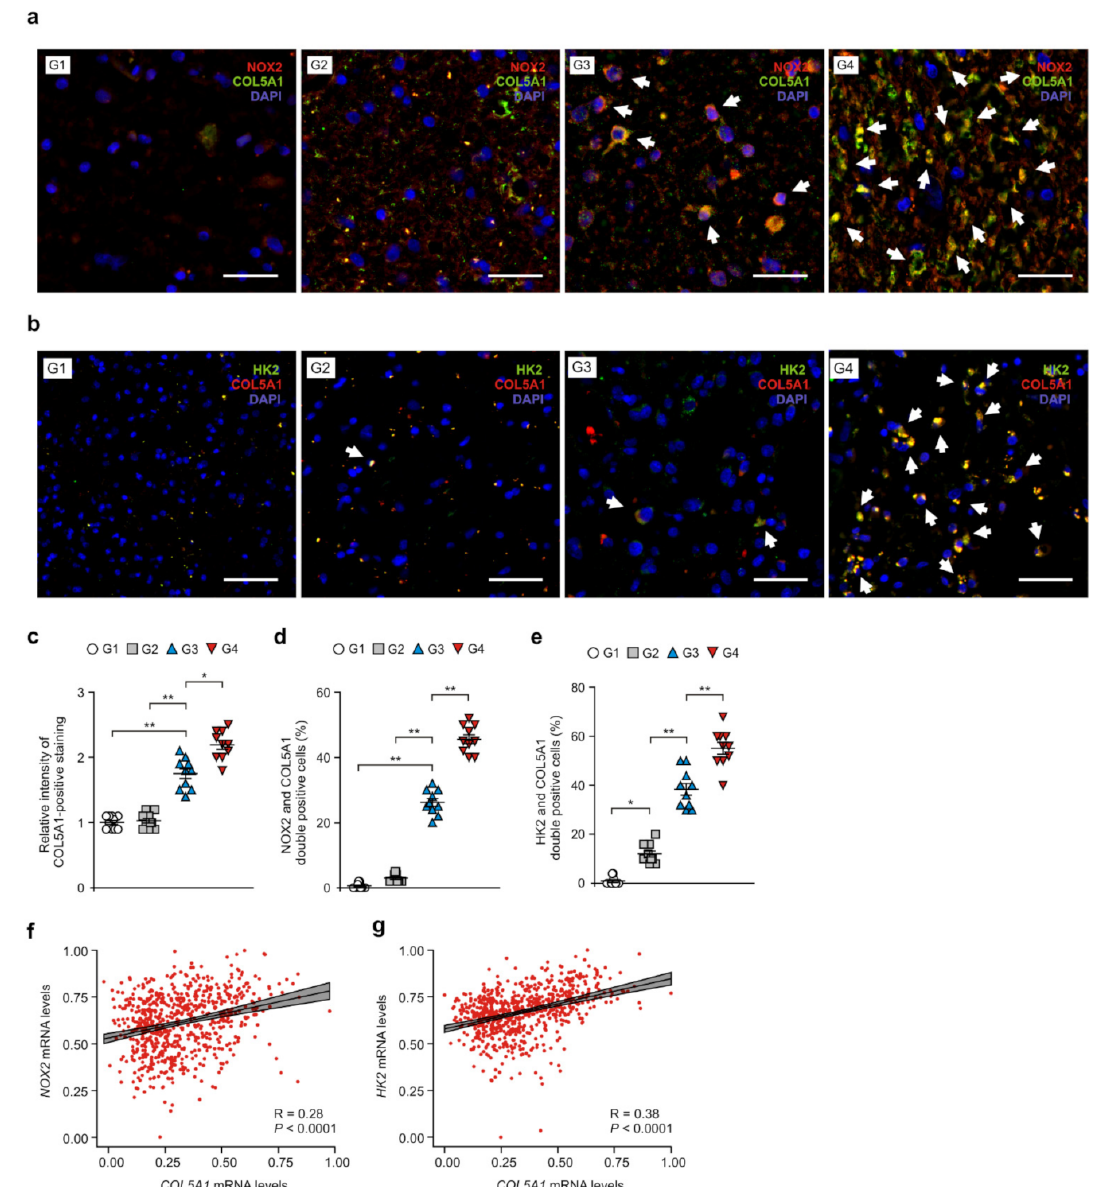
Figure 6. NOX2 and HK2 contributes to the gain of the COL5A1-mediated mesenchymal phenotype in patients with GBM. ( a ) Representative immunofluorescence images of NOX2 and COL5A1 staining in patients with GBM (G4), G3 glioma (G3), G2 glioma (G2), and G1 glioma (G1) showing NOX2 (red), COL5A1 (green), and DAPI-stained nuclei (blue) (n = 3 per group, n = 10 images per individual subject). Scale bars, 20 µ m. White arrows indicate NOX2 and COL5A1-positive cells. ( b ) Representa- tive immunofluorescence images of HK2 and COL5A1 staining in patients with GBM (G4), G3 glioma (G3), G2 glioma (G2), and G1 glioma (G1) showing COL5A1 (red), HK2 (green), and DAPI-stained nuclei (blue) (n = 3 per group, n = 10 images per individual subject). Scale bars, 20 µ m. White arrows indicate HK2 and COL5A1-positive cells. ( c , d ) Relative intensity of COL5A1-positive staining ( c ) and quantification of NOX2 and COL5A1-positive glioma cells ( d ) from ( a ). ( e ) Quantification of HK2 and COL5A1-positive glioma cells from ( b ). ( f ) A Spearman’s correlation coefficient analysis between HK2 and COL5A1 gene patients (n = 693) with GBM and LGG datasets from TCGA. R = 0.28, p < 0.0001. ( g ) Spearman’s correlation coefficient analysis between HK2 and COL5A1 gene patients (n = 693) with GBM and LGG datasets from TCGA. R = 0.38, p < 0.0001. The results are representative of three independent experiments and are shown as the mean ± SEM. ** p < 0.01, * p < 0.05; ANOVA or Student’s two-tailed t